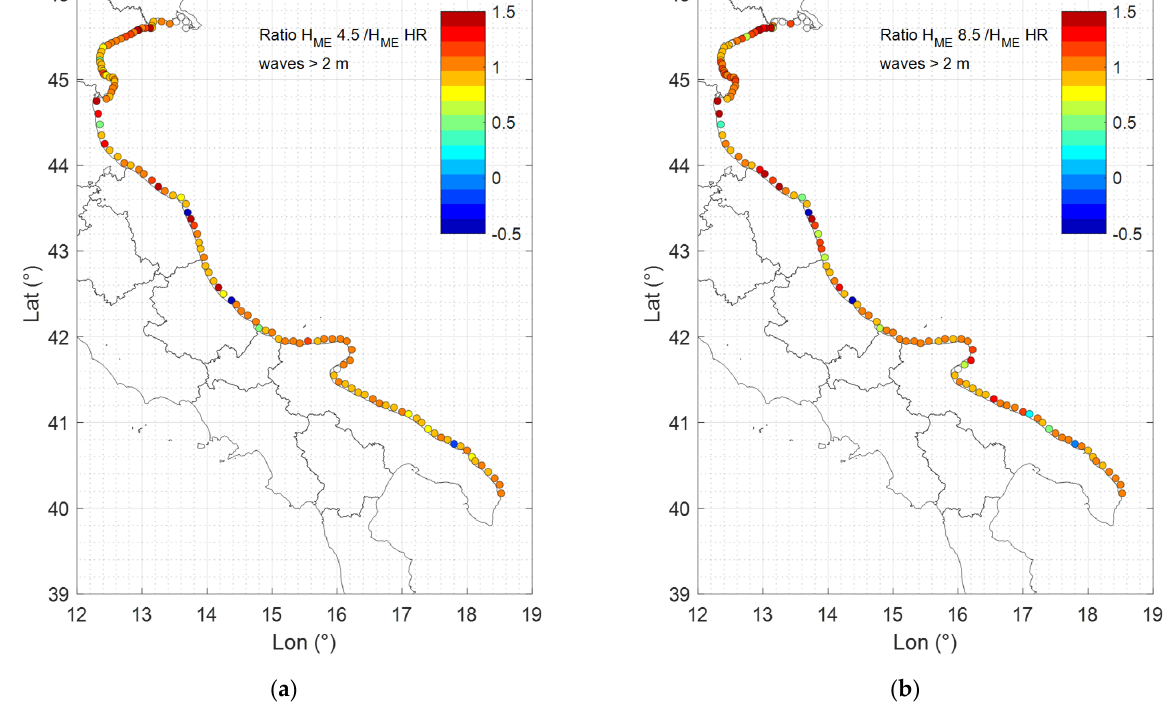
Figure 12. Ratio between historic and future net H ME computed with all the waves larger than 2 m at the 120 virtual buoys along the Italian Adriatic coast. ( a ) Historic run vs. RCP 4.5 scenario; ( b ) historic run vs. RCP 8.5 scenario. Blue points indicate that the direction of the sediment transport is changed.